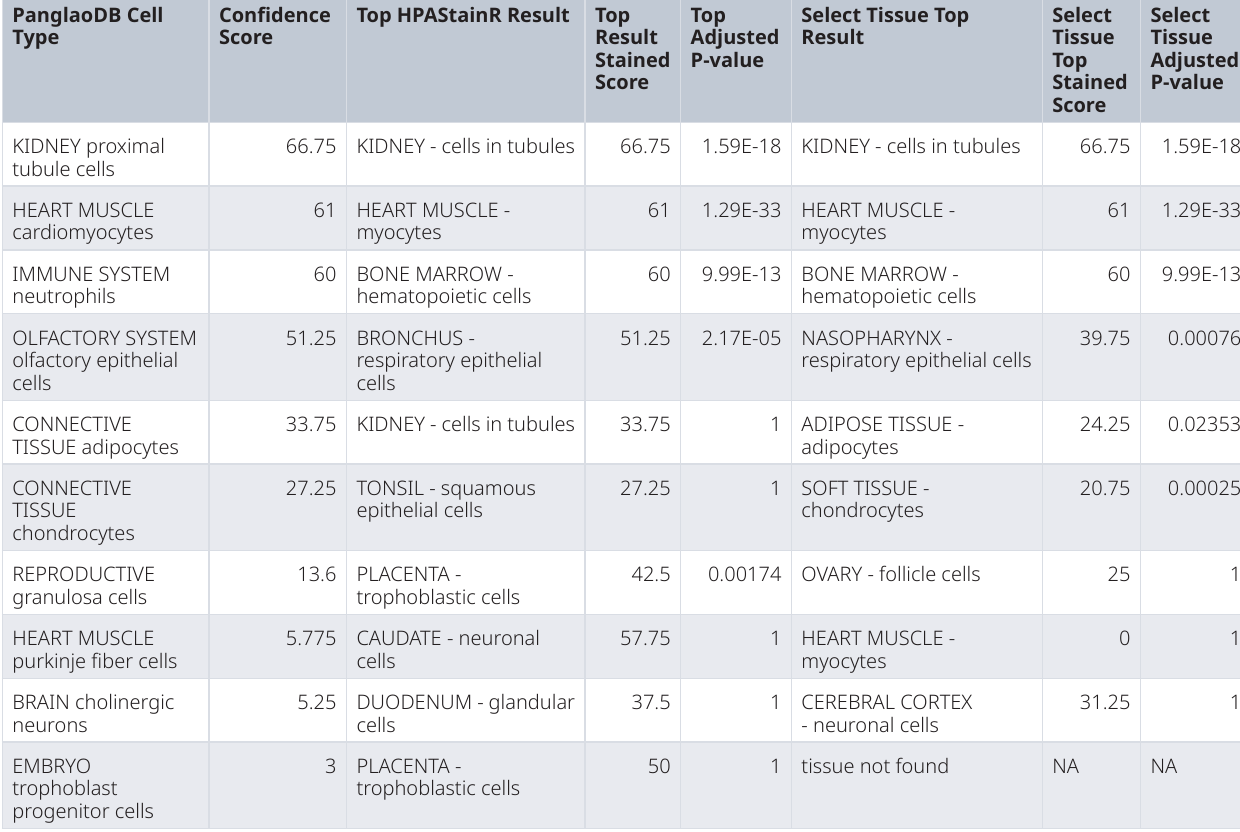
Table 1. A subset of 10 HPAStainR results of PanglaoDB cell type marker queries. Both the overall top HPAStainR result and a tissue-specific result is given. The “Select Tissues” results are from a search performed for the PanglaoDB cell type only within the matched tissue type (ALL CAPITALIZED) in